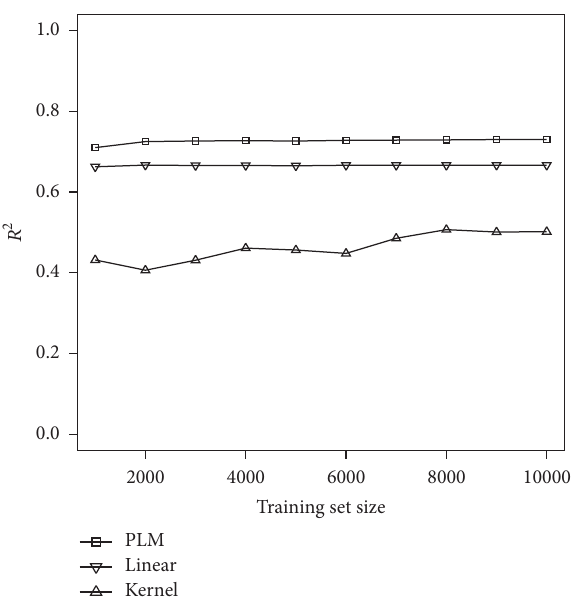
Figure 4: Forecast quality dependence on training set size for synthetic data.